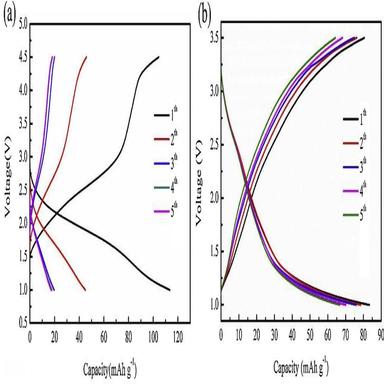
The charge/discharge curves of the FeF3/LBF05@PEO/Li cell at 70 °C and at the current density of 0.1 C between (a) 1.0 V–4.5 V and (b).1.0–3.5 V.